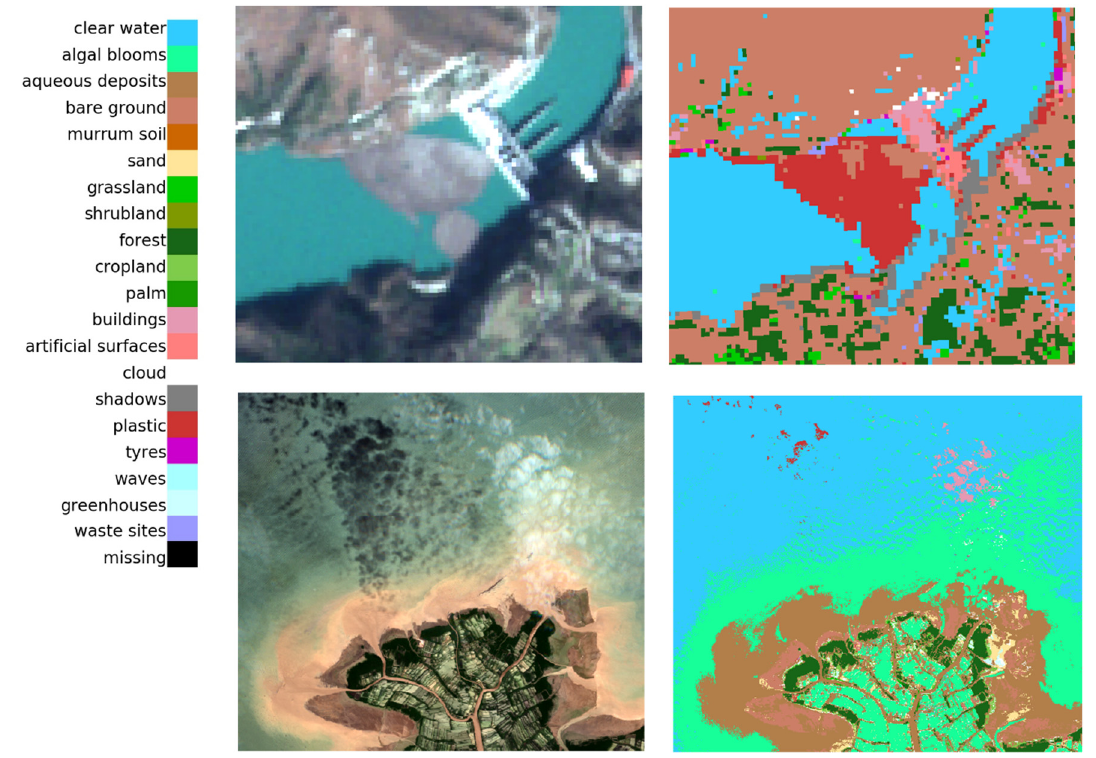
Figure 12. Comparison of the Sentinel-2 pseudo-true colour image (bands B04, B03 and B02 as red, green, and blue) on the left and classification output for the riverine/marine sites on the right. From top to bottom, the subset areas are the Višegrad Dam with plastic (red) detected for the accumulation behind the dam and the Solo River Mouth with plastic (red) pixels in the sea offshore.